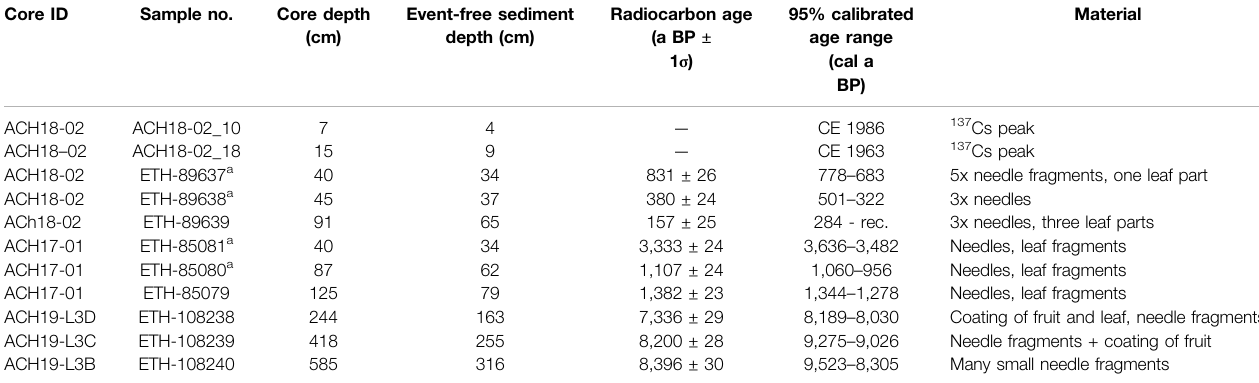
a Samples excluded for age-depth modelling.